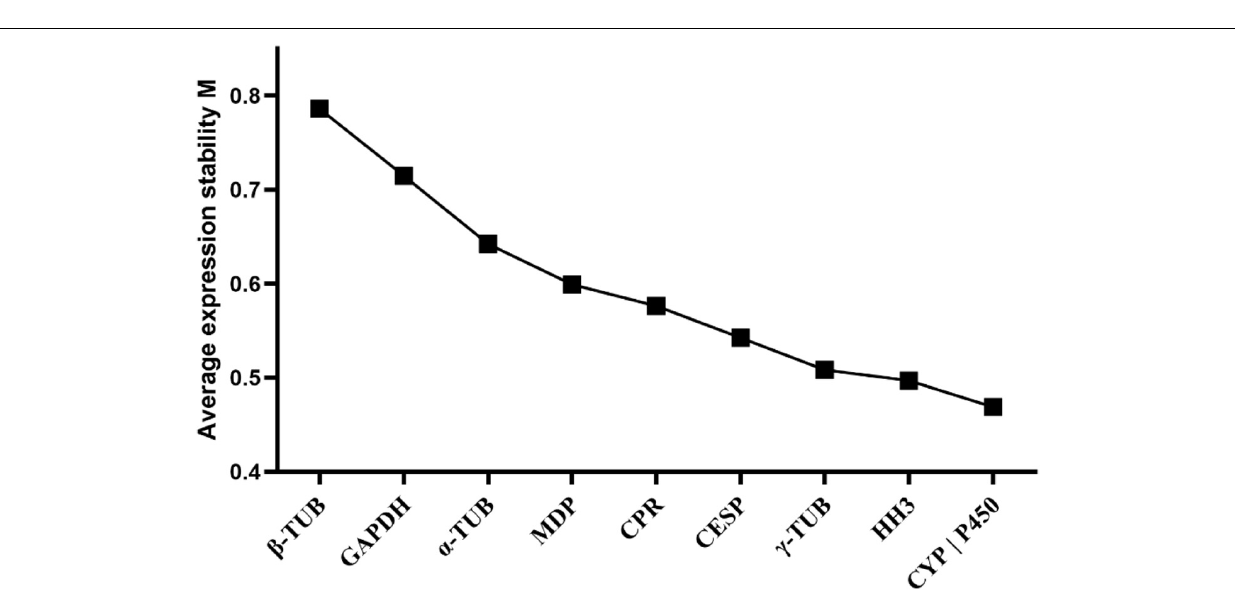
FIGURE 2 | Average expression stability and ranking of the candidate reference genes calculated by geNorm. Candidate reference genes with lower M values were more stable. The least stable genes are listed on the left and the most stable genes are listed on the